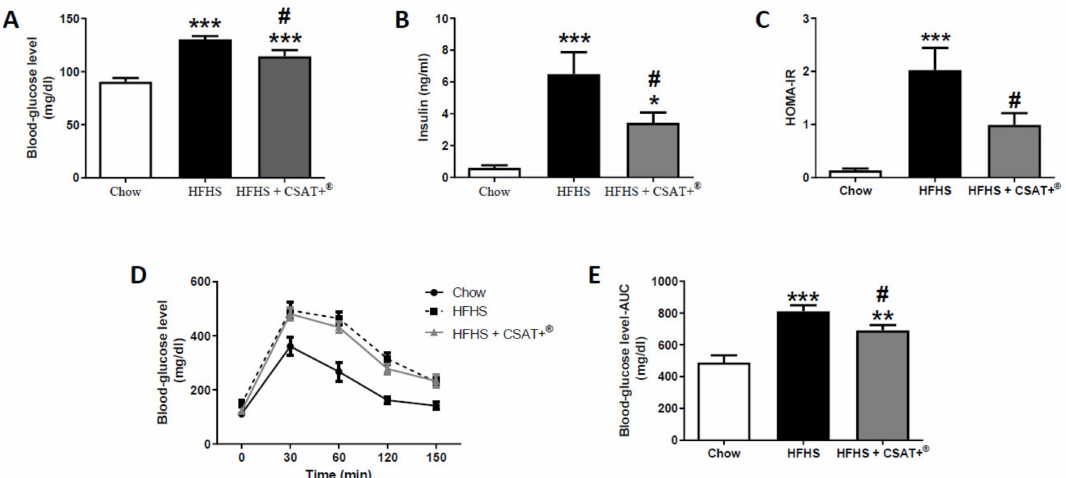
Figure 1. Blood glucose ( A ) and insulin ( B ) plasma levels, Homeostatic Model Assessment of Insulin Resistance (HOMA-IR) ( C ), oral glucose tolerance test ( D ) and area under the curve ( E ) in mice fed a standard diet (Chow), a high fat diet / sucrose diet (HFHS) or high fat diet / sucrose diet supplemented with the carob pod extract (HFHS + CSAT + ® ). * p < 0.05; ** p < 0.01; *** p < 0.001 vs. chow. # p < 0.05 vs. HFHS. Values are represented as mean ± S.E.M; n = 12 samples / experimental group.